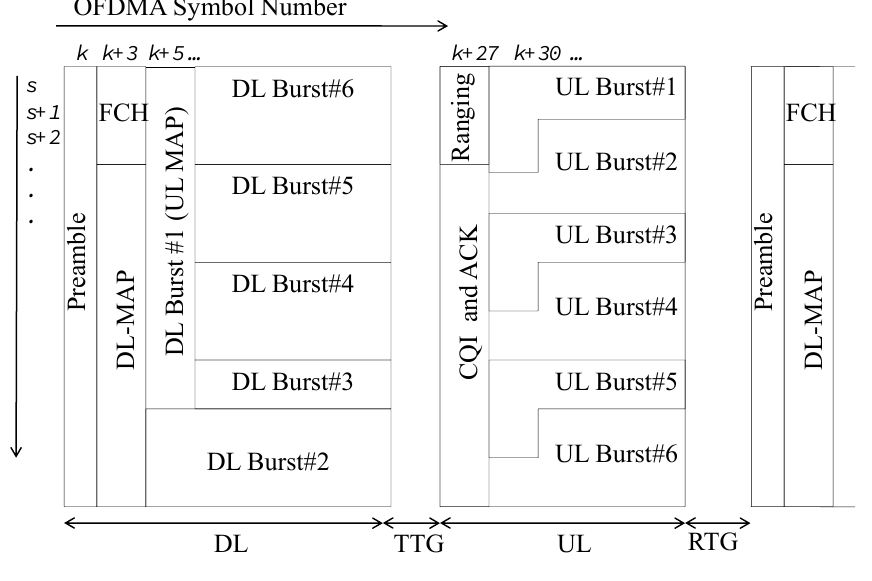
Figure 1. A Sample OFDMA Frame Structure: PUSC